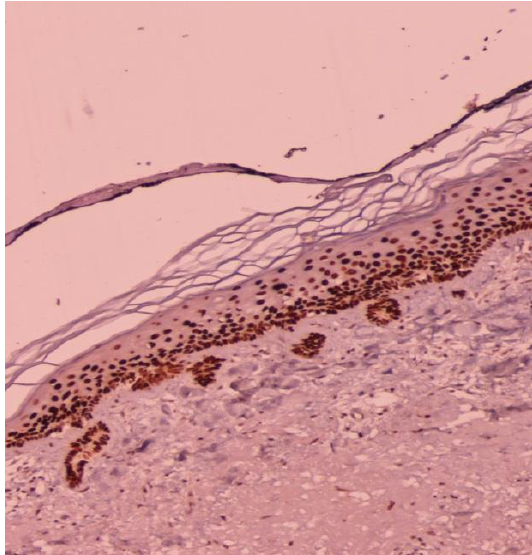
Fig. 2. Strong Epidermal P53 Staining Intensity (×100)